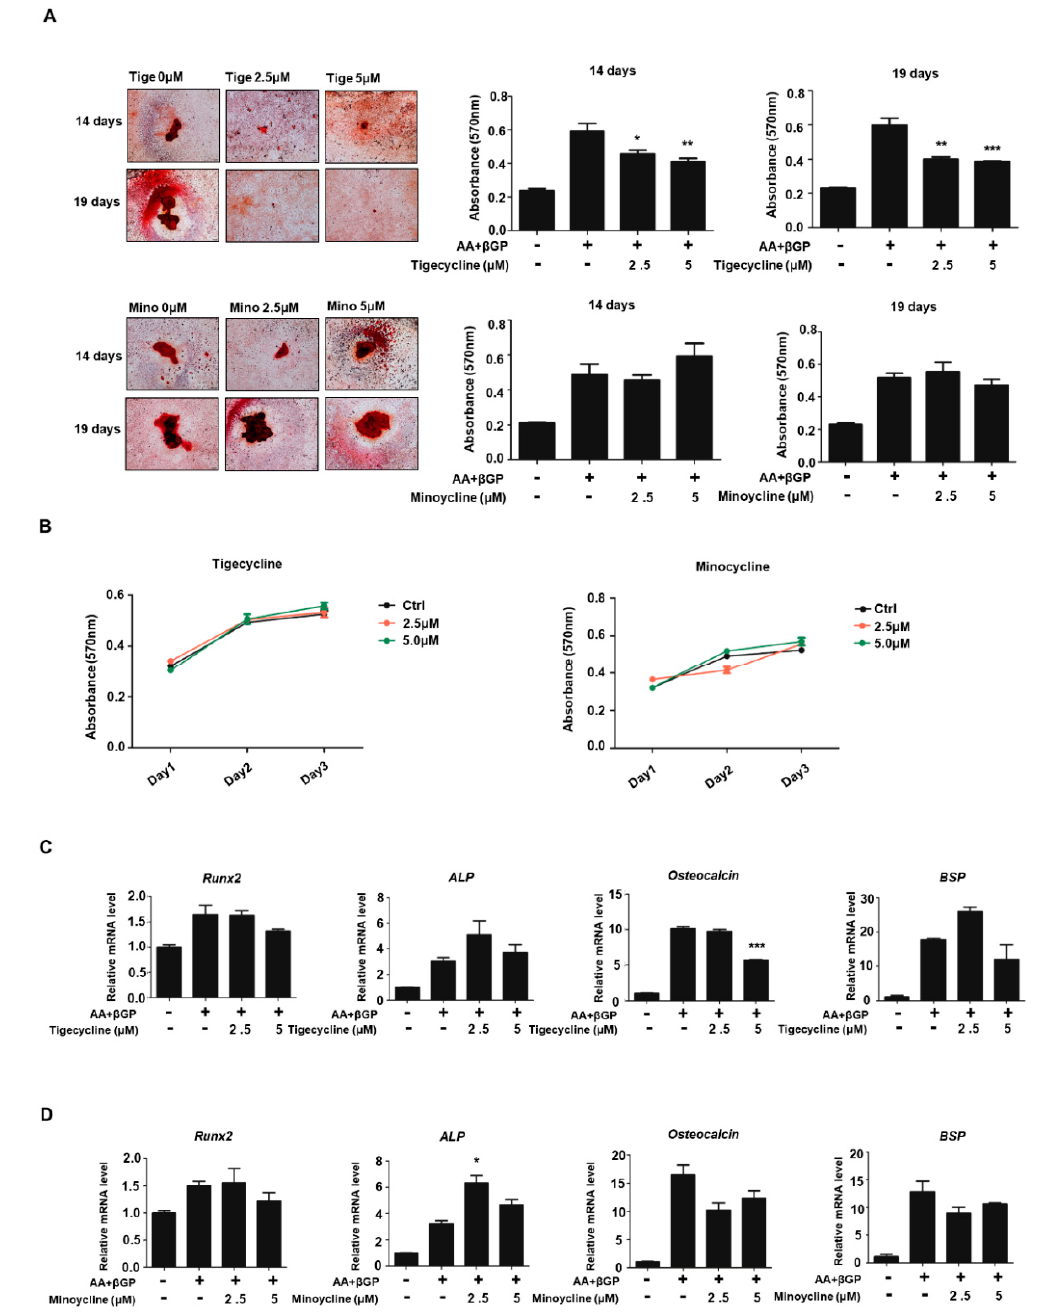
Figure 4. E ff ect of tigecycline and minocycline on osteoblast formation. ( A ) Primary osteoblasts from mouse calvaria were cultured in ascorbate (AA) and β -glycerophosphate ( β -GP), with or without tigecycline or minocycline as indicated, for 14 or 19 days, and the Alizarin red S (ARS) staining for osteoblast di ff erentiation was performed (left panel) and further quantified (middle and right panels). ( B ) Primary osteoblasts were treated with minocycline or tigecycline for three days, and cell proliferation was measured by MTT assays. ( C , D ) Primary osteoblasts were treated with or without tigecycline and minocycline in the di ff erentiation medium, as in ( A ), for four days. Total RNA was prepared, and qRT-PCR was performed using primers specific for Runx2 , ALP , Osteocalcin , and BSP genes. The mRNA levels were normalized to β -actin control. The results shown are mean values from three independent experiments. Error bars represent the mean result ± SD of three independent experiments; * p < 0.05, ** p < 0.001, *** p < 0.0001 (ANOVA analysis), versus only ascorbate and β -glycerophosphate